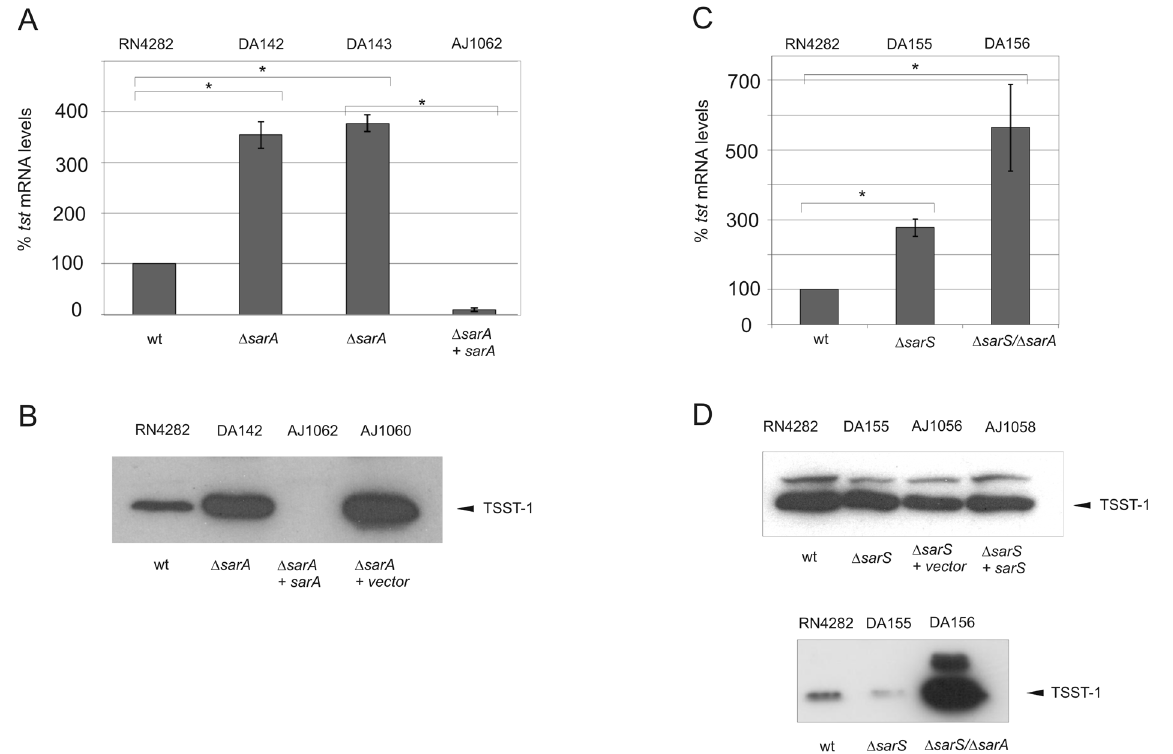
Fig 4. The effect of sarA and sarS on tst and TSST-1 toxin expression in RN4282. A and C. Quantitative qRT-PCR measurements of tst expression in the indicated strains, setting RN4282 as 100%. Bars show +/- standard deviations. All data were compiled from three independent experiments. Statistical significance was evaluated by Student ’ s paired t test, and data were considered significant when P was < 0.05. B and D. Western blot of TSST-1, using anti- TSST-1 polyclonal antibody after precipitation from OD-normalized supernatants of the indicated strains (Materials and Methods). The experiment shown is representative of several independent